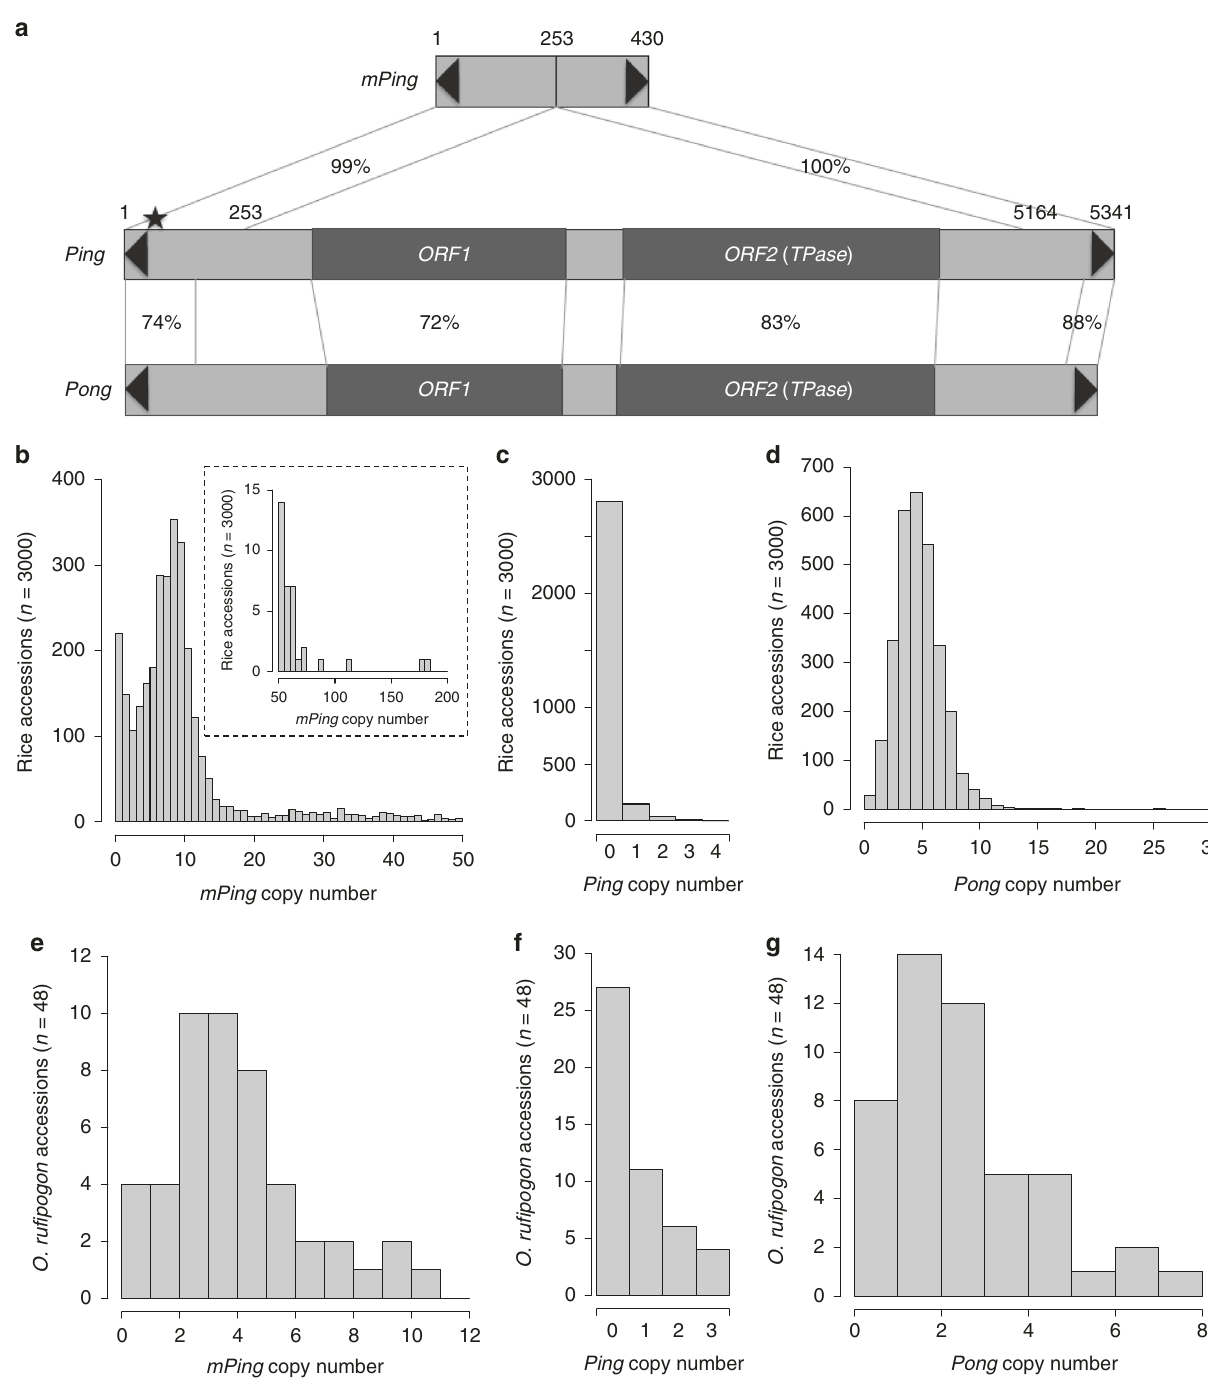
Fig. 1 Abundance of mPing , Ping , and Pong elements in rice and O. ru fi pogon . a Comparison of structures of mPing , Ping, and Pong . TIRs are indicated by black triangles. Two protein-coding genes ORF1 and ORF2 ( TPase ) encoded by Ping or Pong are indicated by dark gray boxes. Homologous regions between elements are connected by lines and percent identities are shown. The black star on Ping indicates the + 16 G/A SNP that differs between mPing and Ping16A . Copy numbers across the 3000 rice accessions of mPing ( b ), Ping ( c ), and Pong ( d ). The bar plot in the dashed box in b shows accessions with >50 mPing elements. e , mPing copy number of 48 O. ru fi pogon accessions. f Ping copy number of 48 O. ru fi pogon accessions. g Pong copy number of 48 O. ru fi pogon accessions. Source data for Fig. 1b – g are provided in Supplementary Data